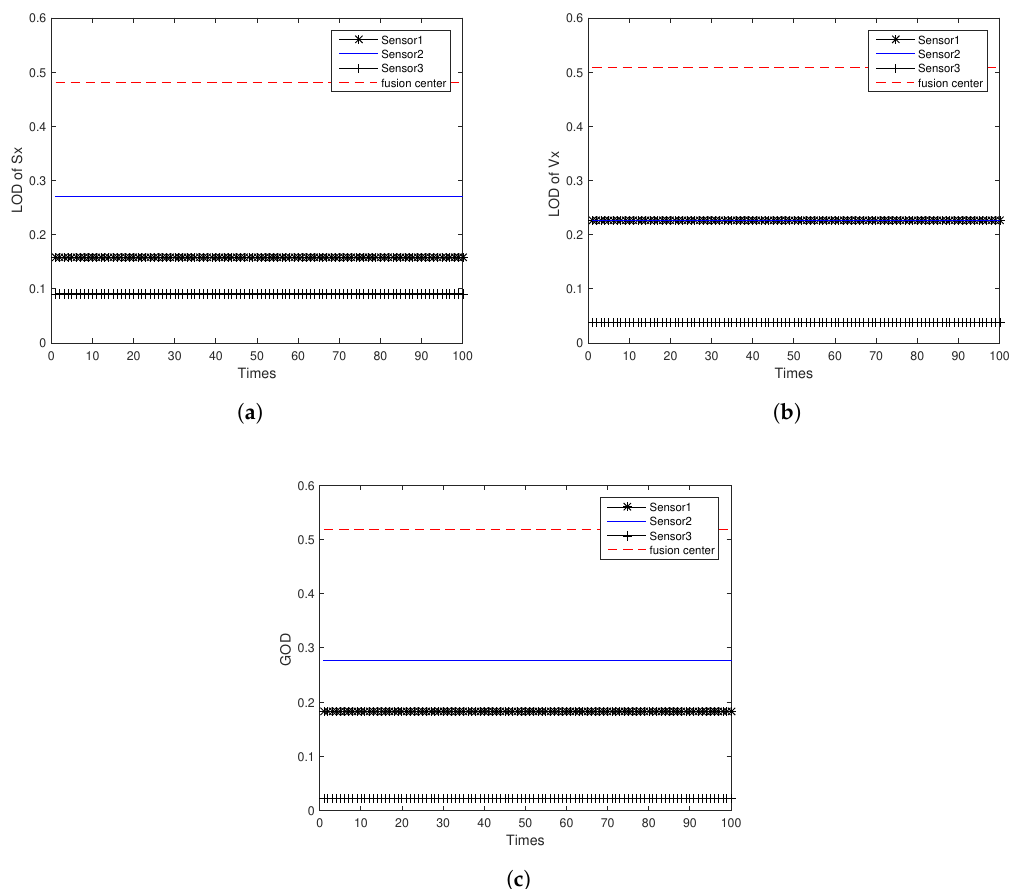
Figure 5. Observable degree comparison between local filter and fusion center in distributed multi-sensor fusion system without feedback: ( a ) LOD of Sx; ( b ) LOD of Vx; ( c ) GOD.